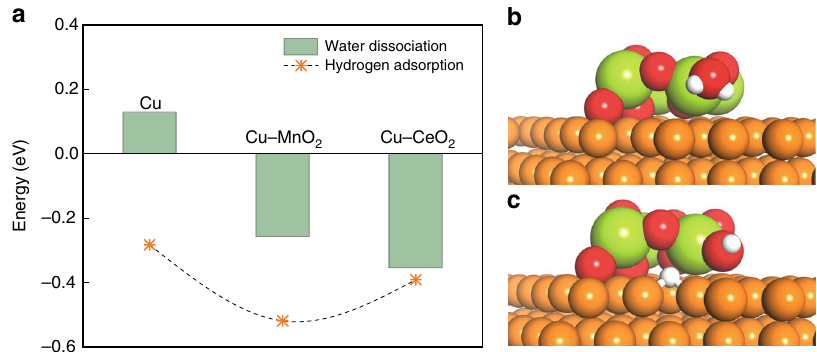
Fig. 1 Water activation on oxide-modi fi ed Cu surfaces. a Calculated water dissociation reaction energies and hydrogen adsorption energies on various surfaces. b Surface con fi gurations of CeO 2 /Cu with and c without adsorbed